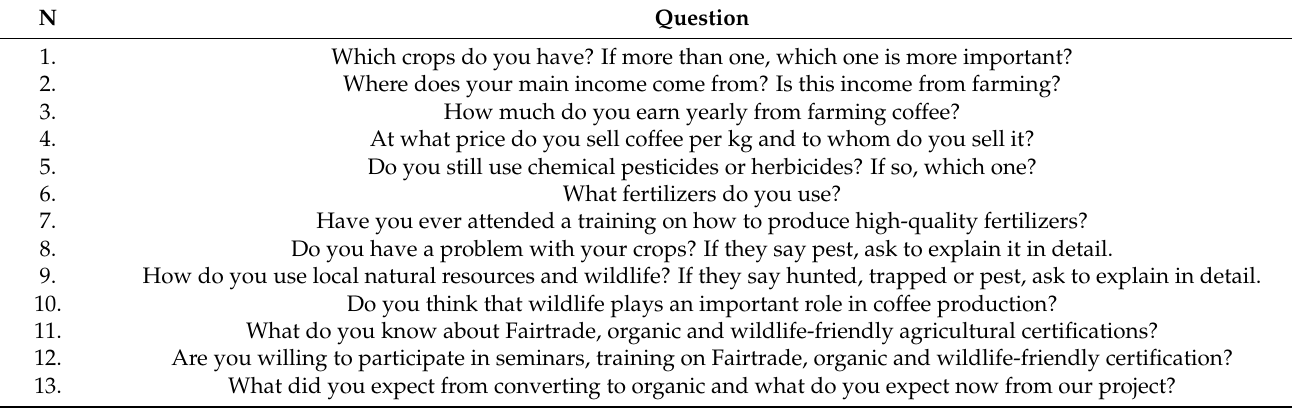
Table 2. Open-ended questions used in the interviews with 25 coffee farmers in Pangauban village, West Java. We also took note of sex and age of